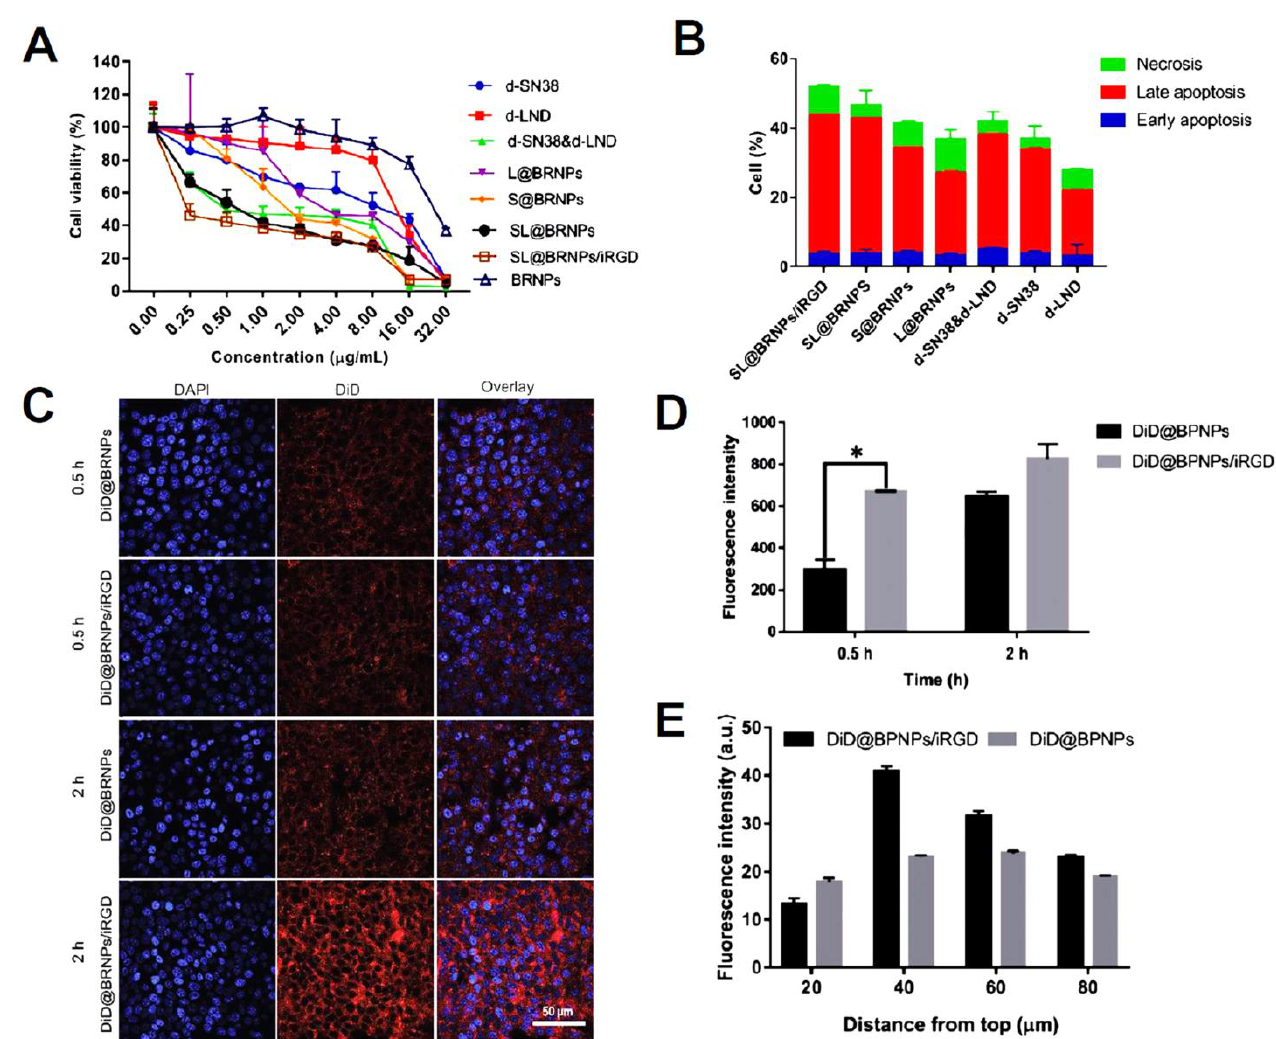
Figure 5. ( A ) Cell viability by MTT assay. ( B ) Apoptosis results from various groups. ( C ) 4T1 cells treated with nanoparticles for 0.5 and 2 h by confocal microscopy. ( D ) Flow cytometry data of cellular uptake. (* p < 0.05) ( E ) Analysis of tumors at various depths via fluorescence semi-quantification. Reproduced from Yang et al. [136], with permission from John Wiley and Sons.